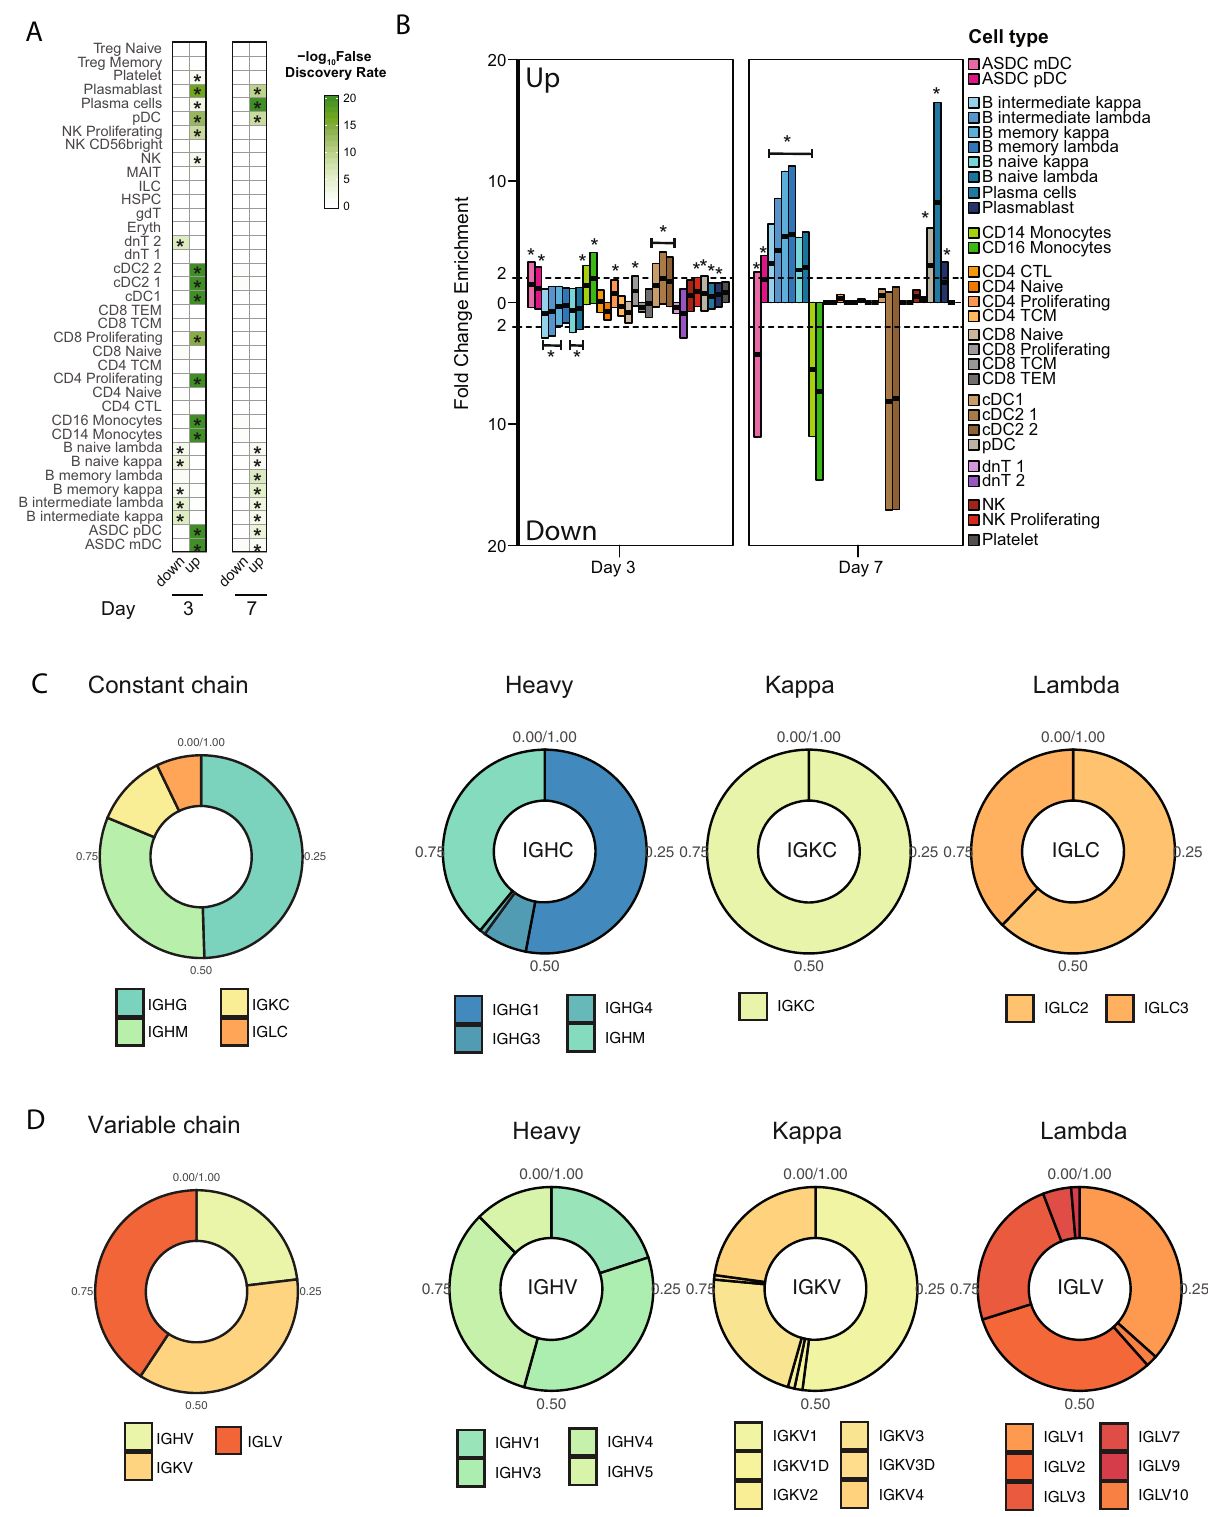
Fig. 4 Cell type deconvolution and induction of immunoglobulin genes in G4. A Main cell types enriched or depleted in the peripheral blood of patients after priming with IIV8/AS03 compared to baseline (day 1) on day 3 and 7. Asterisk indicates FDR < 0.05 (Fisher ’ s exact test, cell type reference from ref. 16 ). B ) Fold change enrichment of intersected gene sets of G4 after cell type deconvolution on day 3 and 7. Bar indicates fold change enrichment (up) or depletion (down) for each cell type on day 3 and 7. Asterisk indicates FDR < 0.05 (Fisher ’ s exact test). C , D Relative abundance of immunoglobulin transcripts on day 7 after priming with IIV8/AS03. Relative proportion of enriched isotypes and subclass transcripts corresponding to VJ recombination is shown for the constant ( C ) and the variable ( D ) heavy, kappa, and lambda chains (IGH, IGK, and